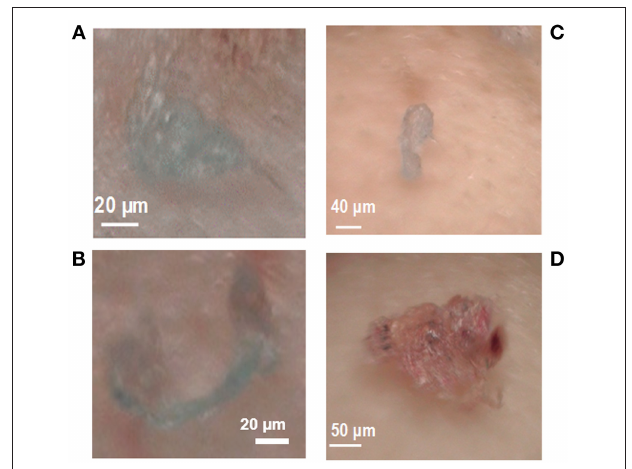
FIGURE 1 | Particles of PE and PP in the digestive gland (A,B) of mussels Mytilus spp. exposed to 100 µ g L − 1 and biodeposits (C,D) of mussels exposed to 10 and 100 µ g L − 1 ,